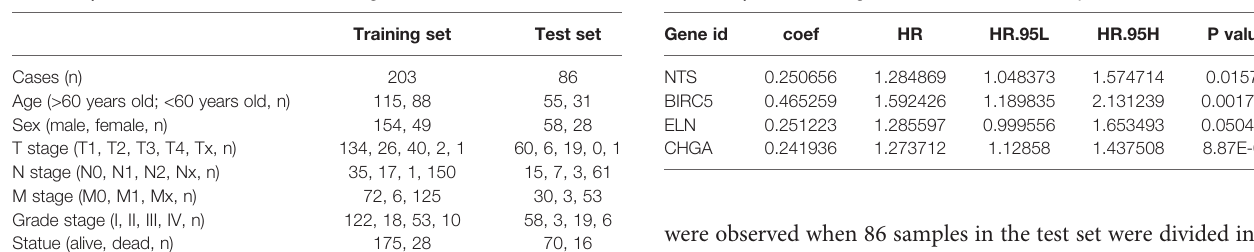
TABLE 1 | The clinical information of the training set and the test set.